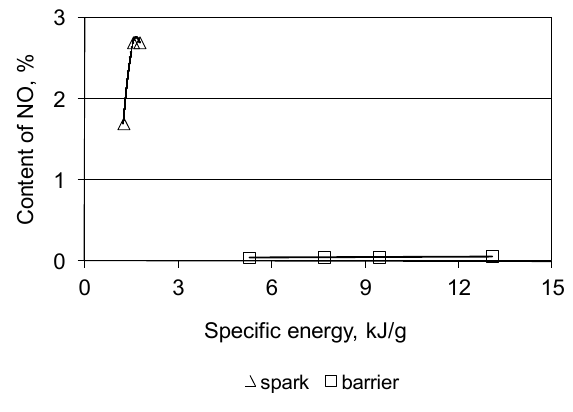
Figure 7 : The dependence between the NO content and specific energy for the barrier and spark discharges.